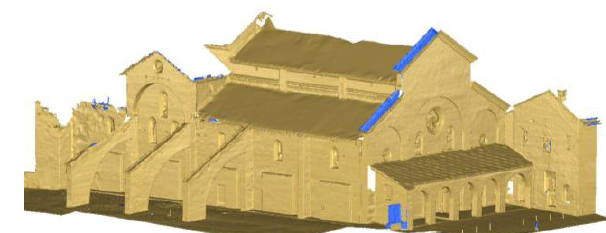
Figure 4. Final 3DModel after the merger between the two distinct mesh (front/roofs)